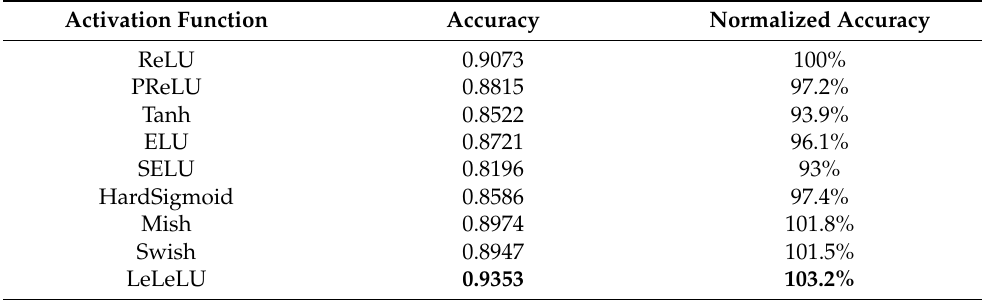
Table 3. Test accuracy in the Sign Language dataset of the activation functions in question, using the corresponding neural network, and accuracy normalized to that attained by ReLU activation function.